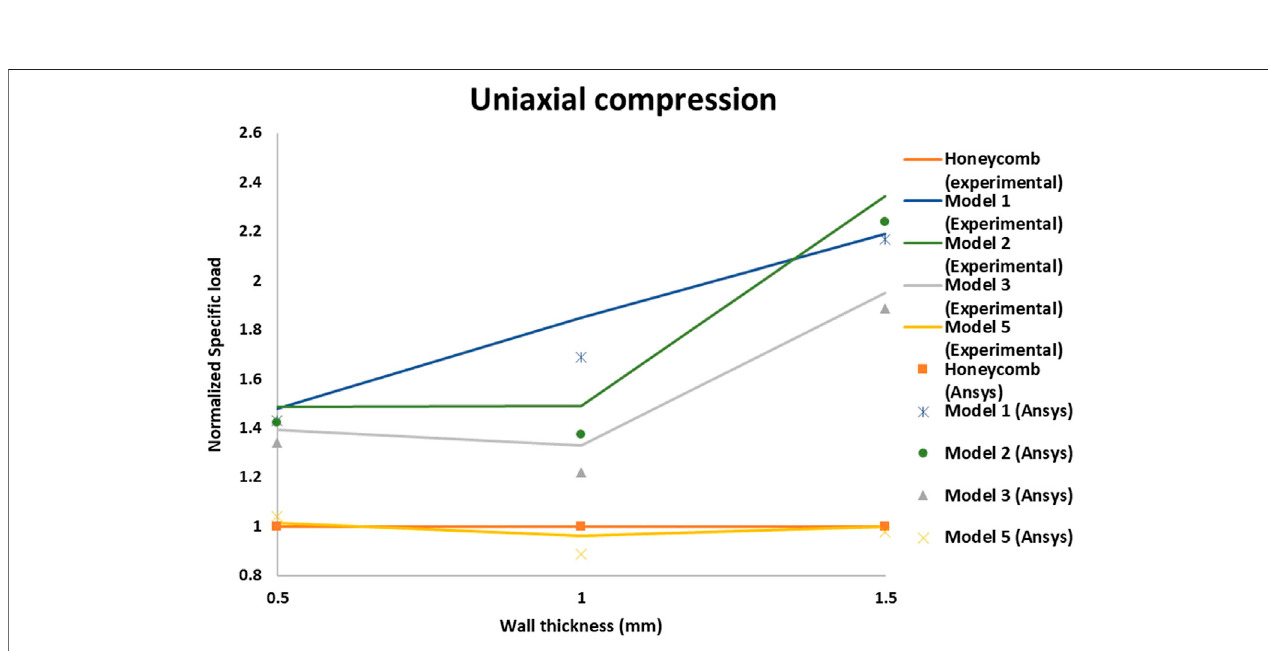
FIGURE 8 | Experimental and simulation Wall Thickness versus Normalized Speci fi c load comparison for several cellular structures under uniaxial compression.